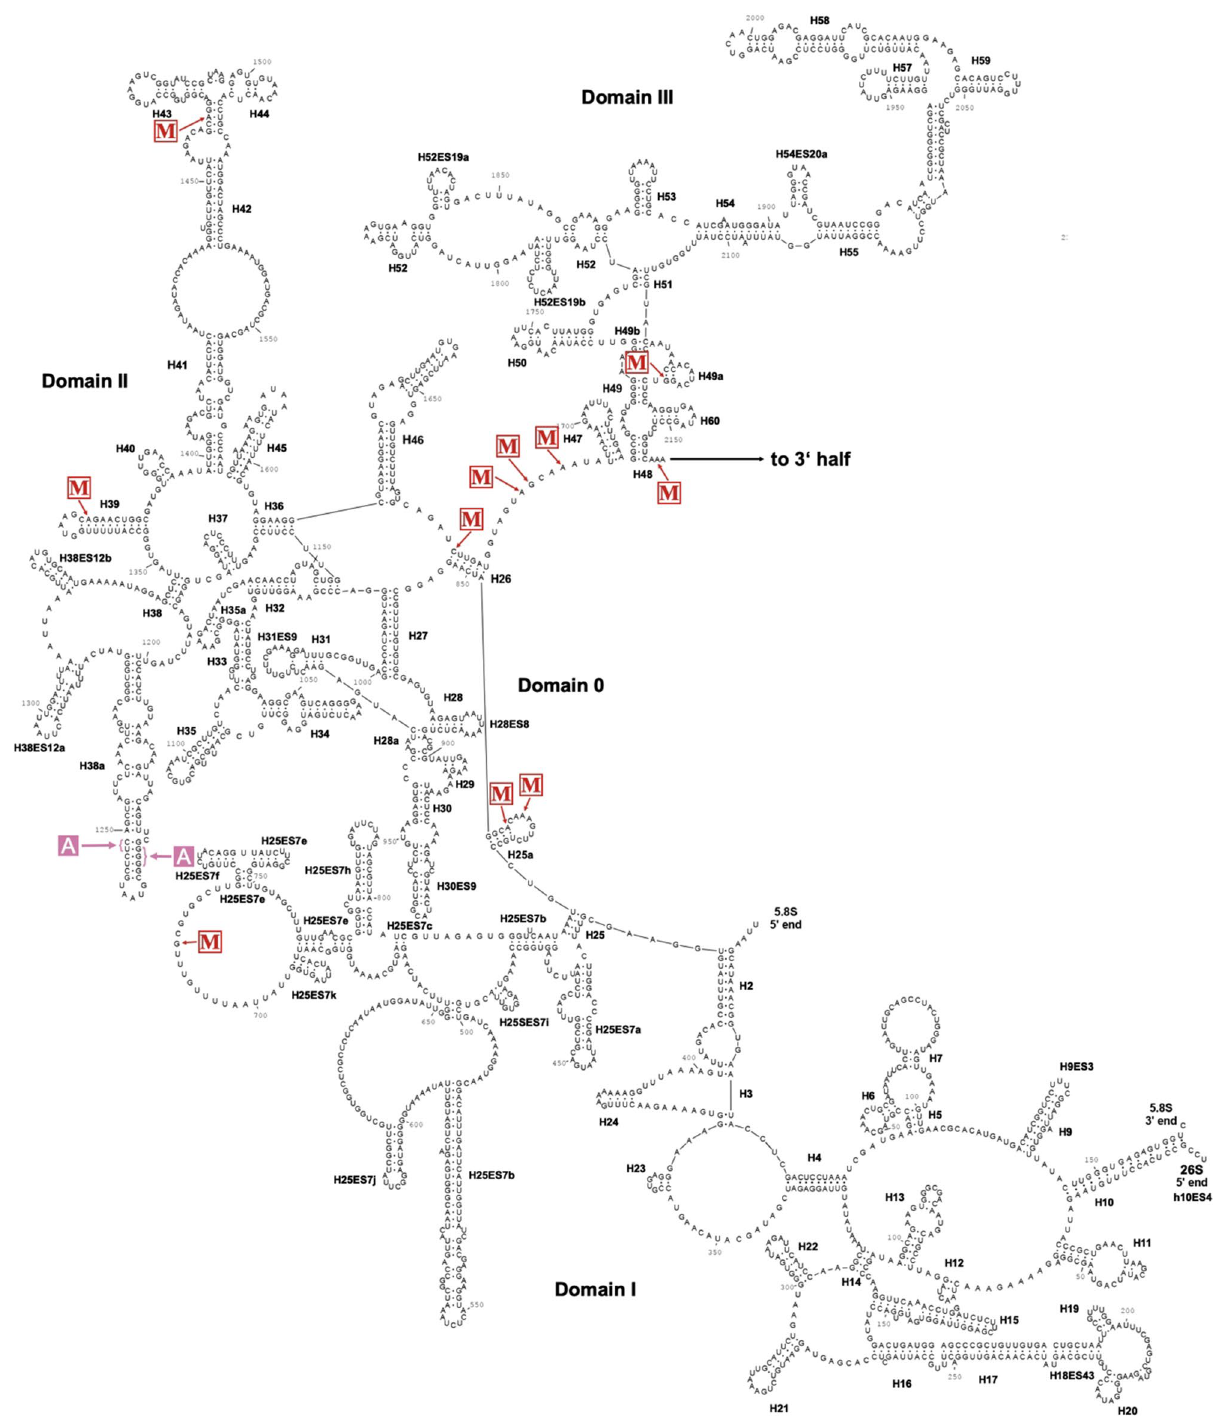
Figure 4. Secondary structure of the 26S rRNA of D. discoideum with 2 ′ - O -Me sites. The secondary structure of the 26S rRNA was inferred by homology and drawn using RNAviz (v. 2.0.3). The 2 ′ - O -methylated nucleotides as identified by RiboMeth-seq are marked with an arrow and ‘M’ (red). Nucleotides located in the A, P, and E sites of the ribosome are indicated in pink. Due to the size of the 26S rRNA, the figure is split into the 5 ′ half and 3 ′ half. The predicted interaction with the 5.8S rRNA is shown at the 5 ′ end. Helices (Hx) are named to convention and expansion segments (ESx) are